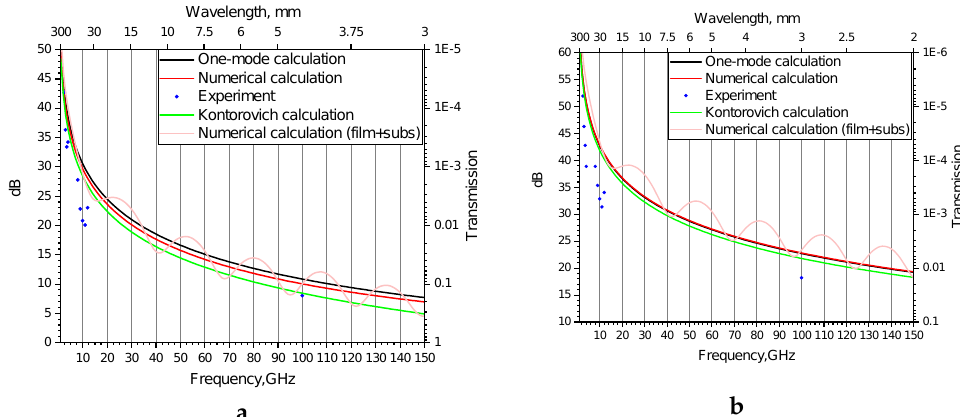
Figure 4. Comparison of the experimental transmission of a mesh structure on K108 glass with a numerical calculation of the transmission of the mesh structure on OHARA S-BSL7/Schott N-BK7 glass, and the model and numerical calculations of free-standing mesh structure transmission for sample 1 ( a ) and sample 2 ( b ).